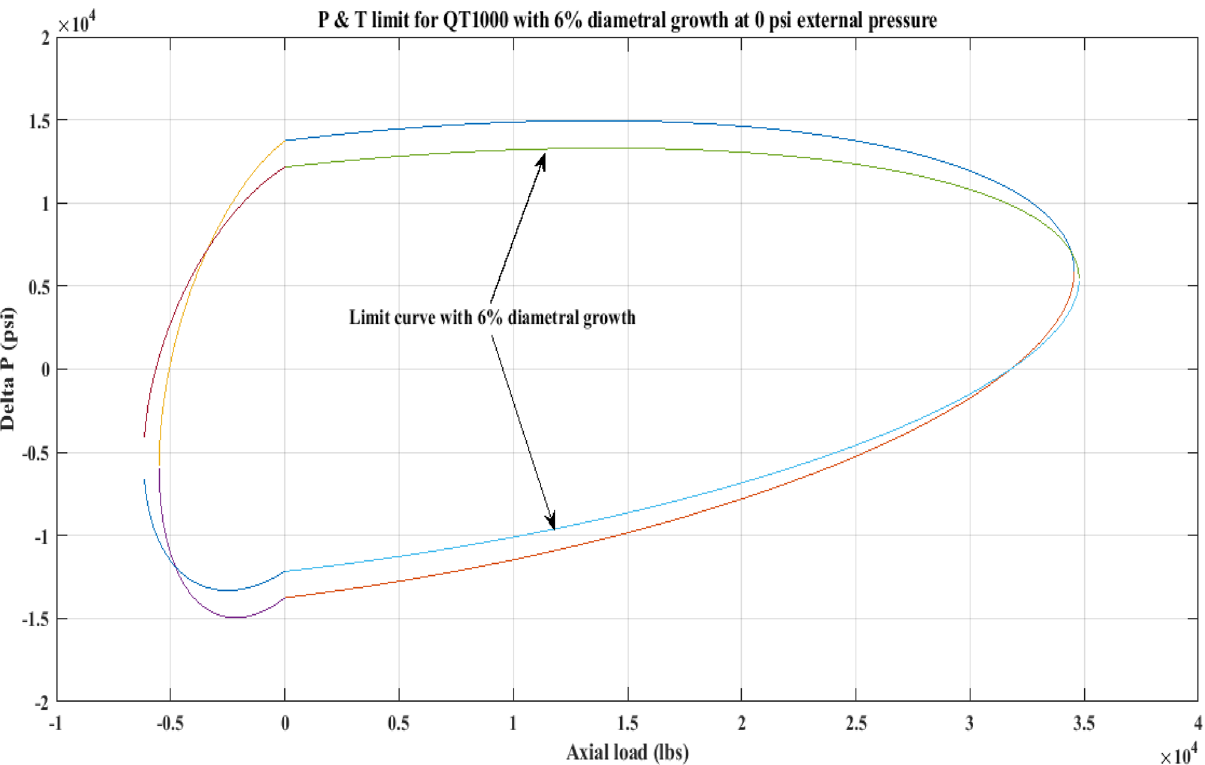
Figure 13. P and T limit with diameter growth for QT 1000 at 0 P o .